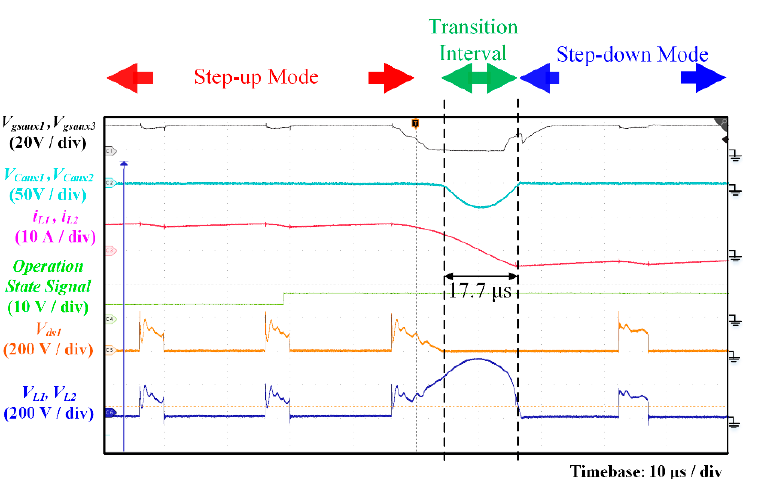
Figure 20. Experimental waveforms of transition from step-up mode to step-down mode under full-load conditions.